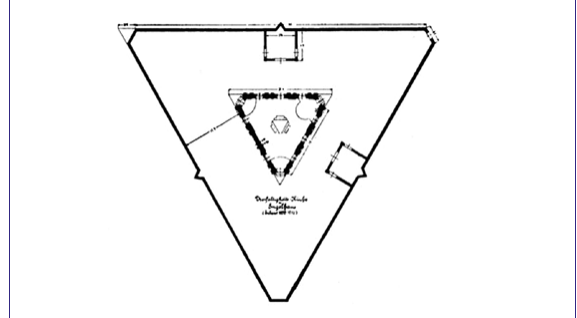
fig. 3. andělská Hora. Holy Trinity church, G. H. alliprandi, 1696–1702. General plan after Gustav Kutschera 1908. Source :